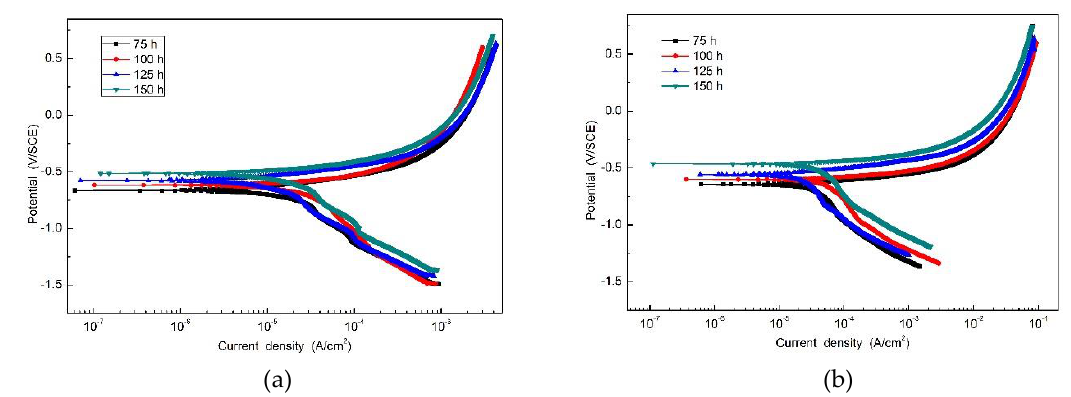
Figure 7. Potentiodynamic polarization curve of ( a ) SMA490BW steel and ( b ) welded joints after the periodic immersion wet/dry cyclic corrosion test.